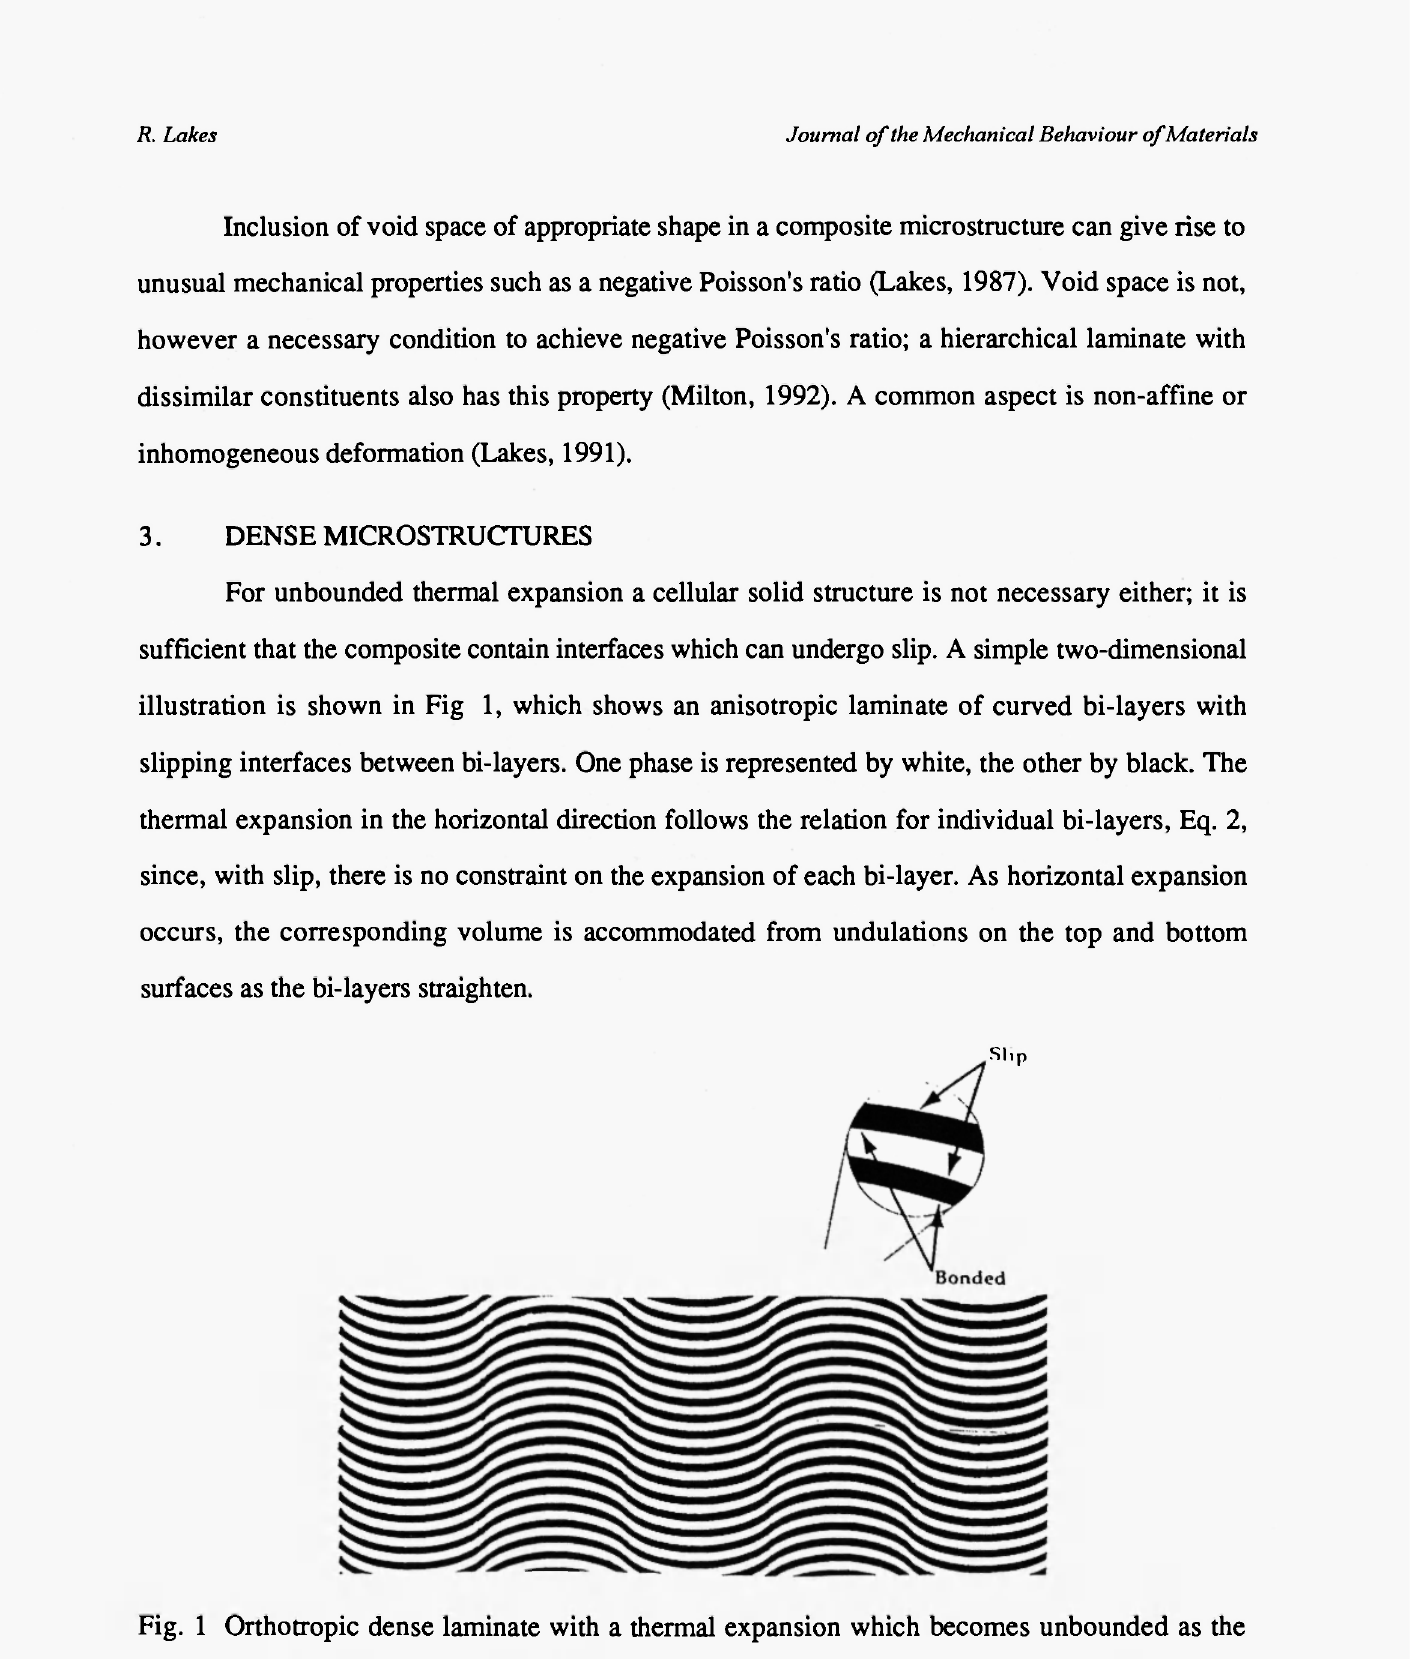
Fig. 1 Orthotopic dense laminate with a thermal expansion which becomes unbounded as the strip thickness becomes small. One phase is represented by white, the other by